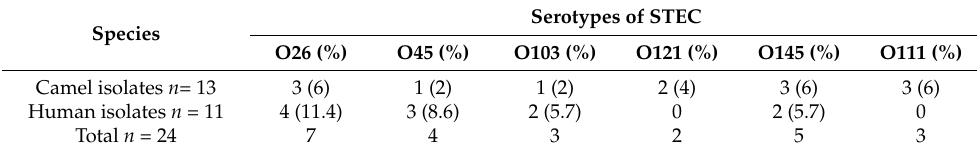
Table 6. Serotyping of E. coli isolates.